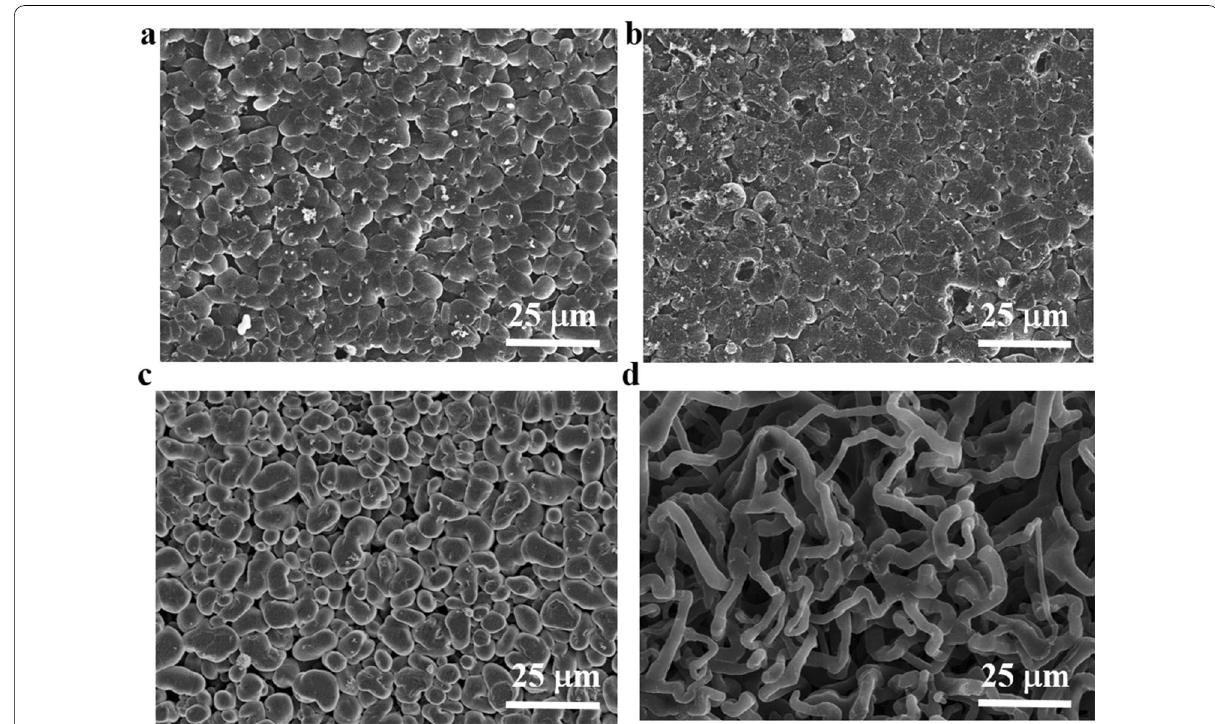
Fig. 3 Surface morphologies of the a unspoiled RI||Li, b corroded RI||Li, c unspoiled Li, and d corroded Li after the 10th galvanostatic Li stripping/ plating cycle with a current density of 1 mA cm − 2 and a capacity of 1 mAh cm −